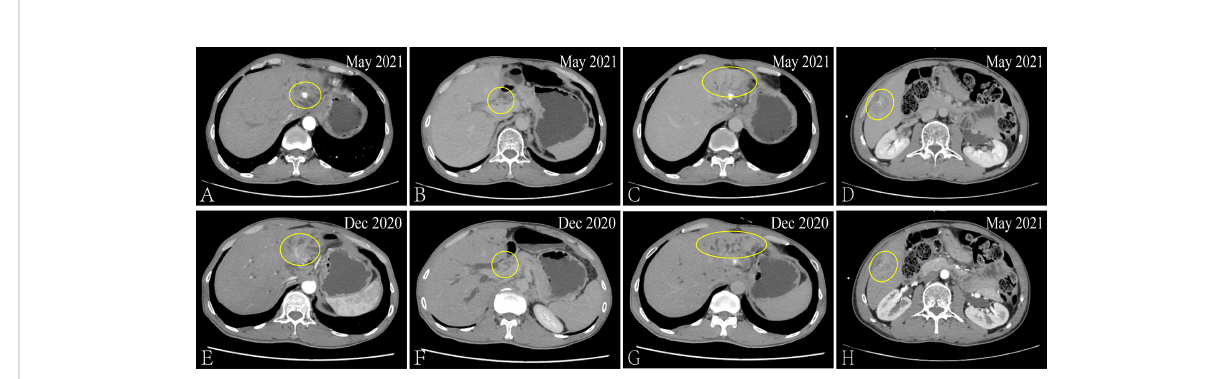
FIGURE 2 Via CT to contrast the curative effect between the May 2021 and Dec 2020. The size of the metastatic lesion which in the left and caudate lobe of liver is reduction from 3.4 × 2.6cm to 2.6 × 2.1cm (A, E) . The hepatic portal metastatic nodule has disappeared (B, F) and the compressive bile duct has improvement (C, G) . The new metastatic lesion (2.7 × 1.7cm) in liver S5 (D, H)